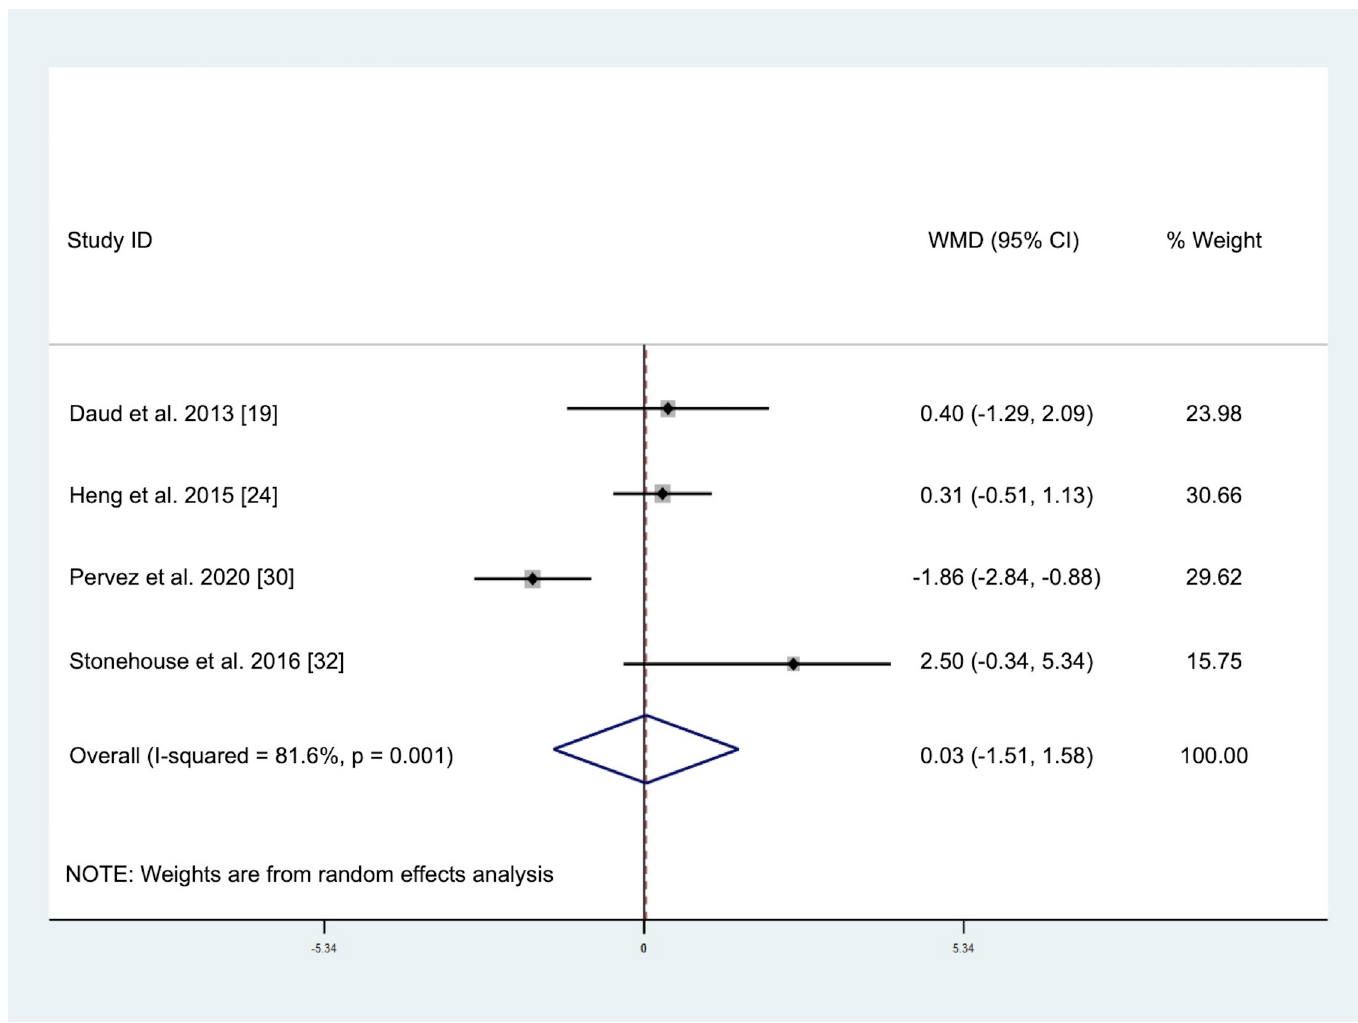
Fig 3. Forrest plot on the effect of tocotrienols supplementation on interleukin-6 levels.